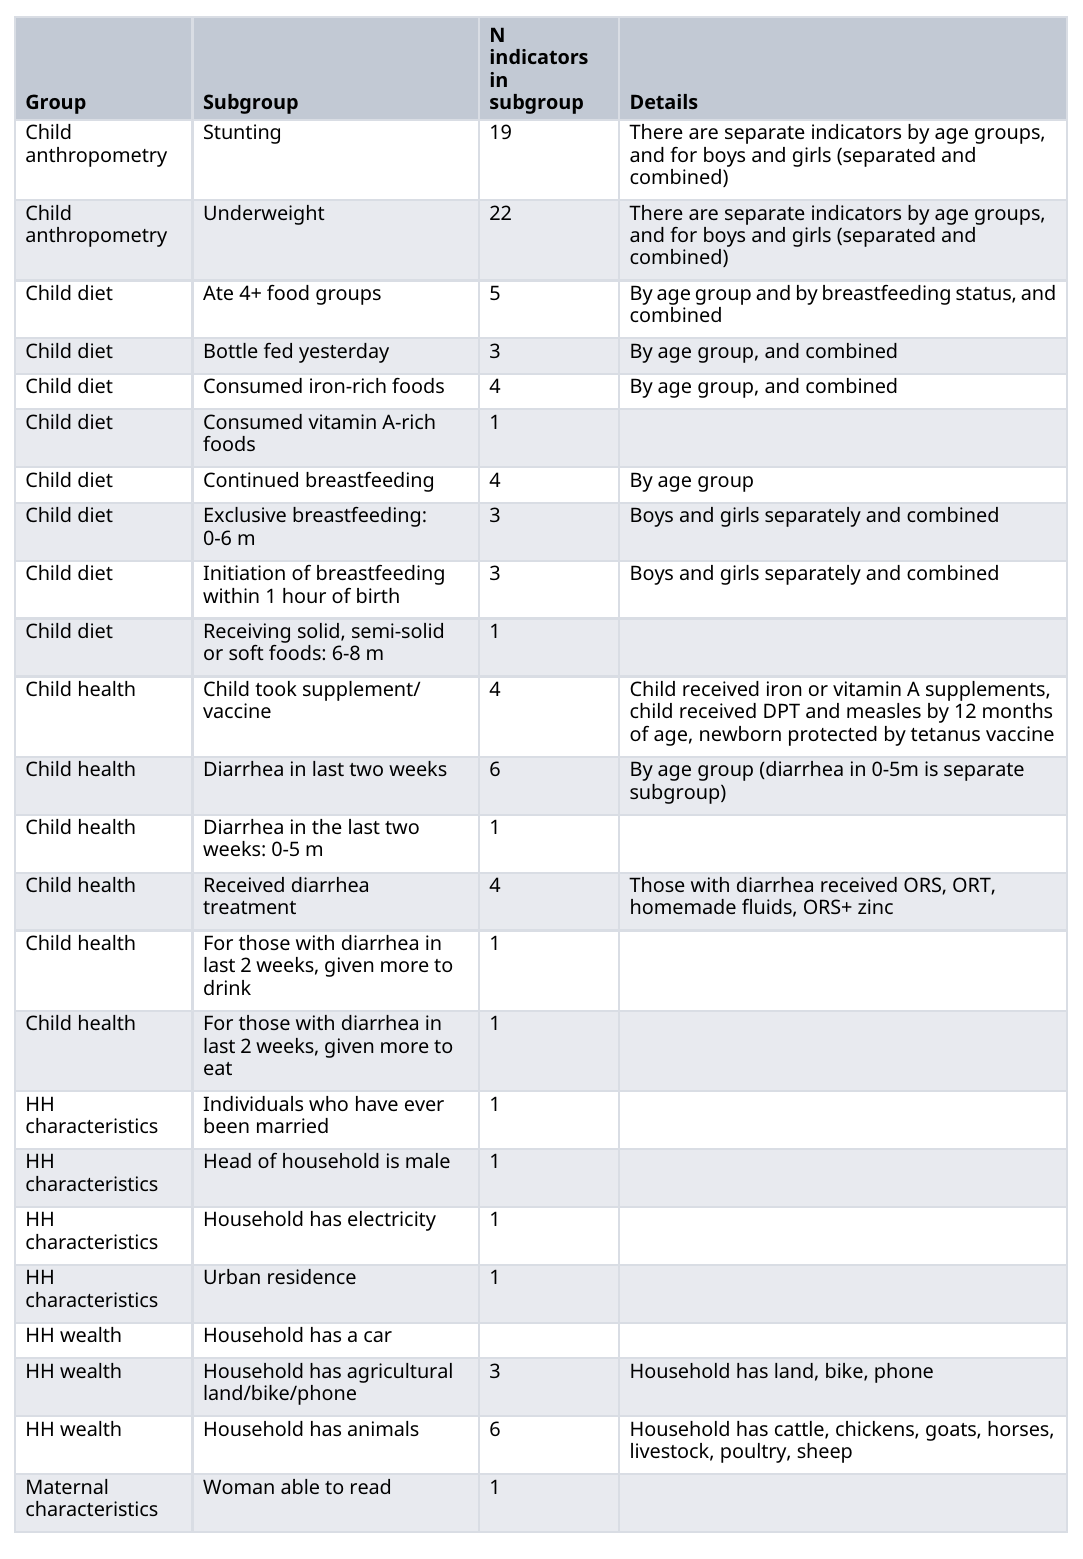
Table 3. List of indicators collected by group and subgroup* Group Subgroup